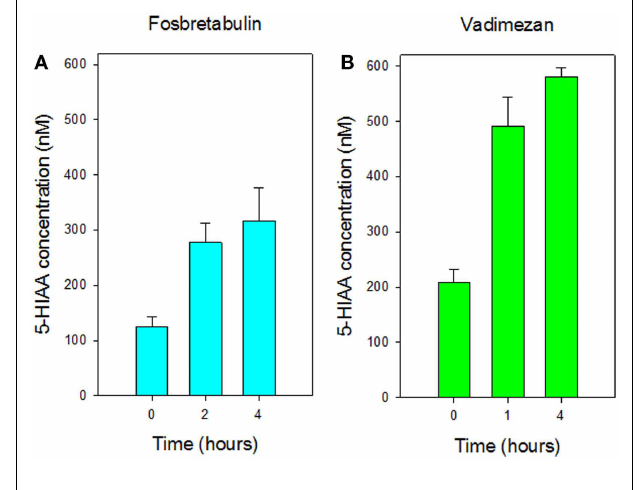
FIGURE 2 | Comparison of plasma concentrations of 5-HIAA in non-tumor-bearing mice following i.p. administration of (A) fosbretabulin (25mg/kg) and (B) vadimezan (25mg/kg) . Data for vadimezan are extracted from a previous publication (36).Vertical bars represent SEM (three mice per